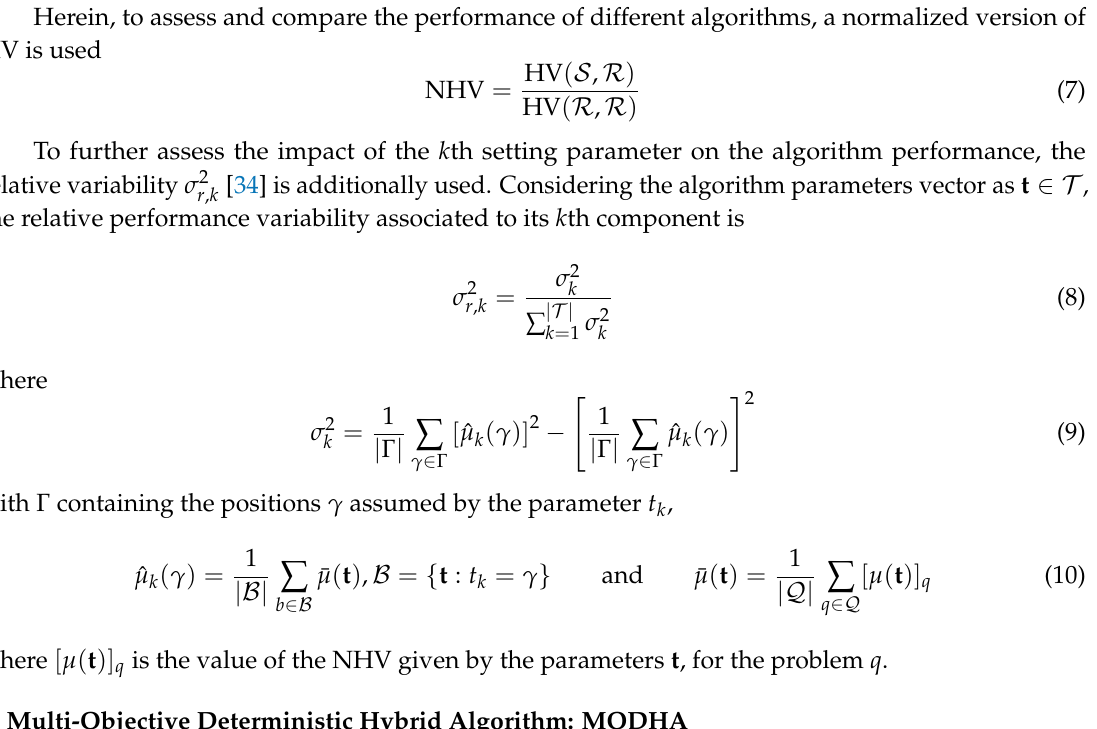
Figure 1. Hypervolume